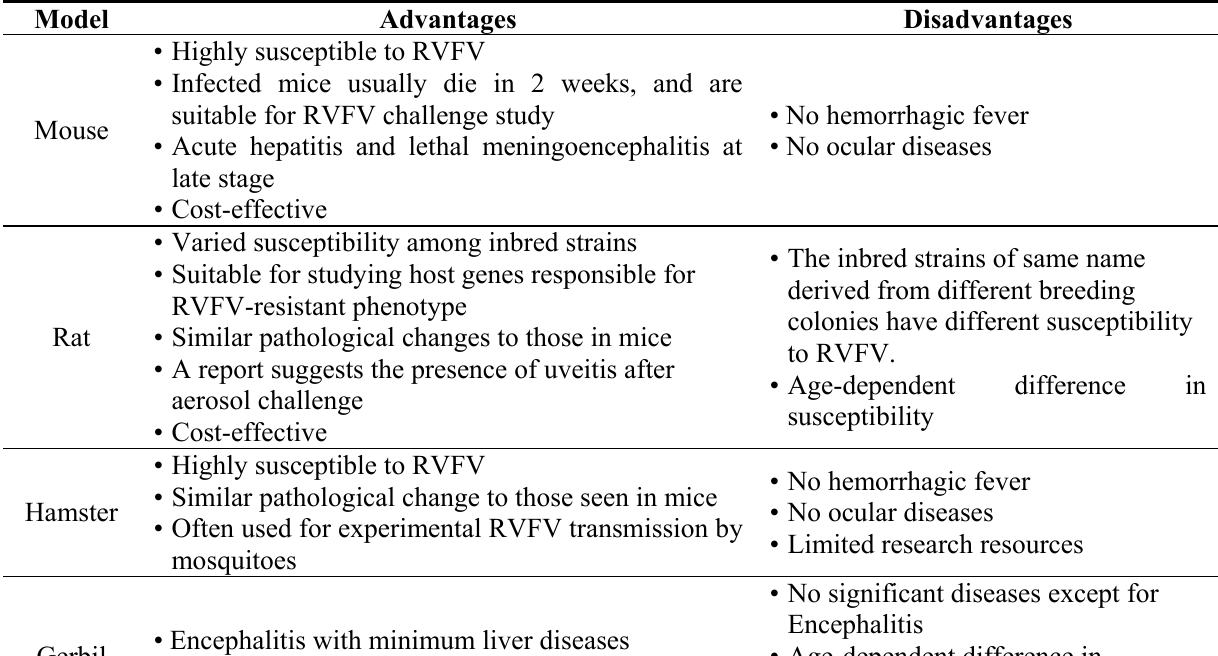
Table 1. Advantages and disadvantages of animal models for Rift Valley